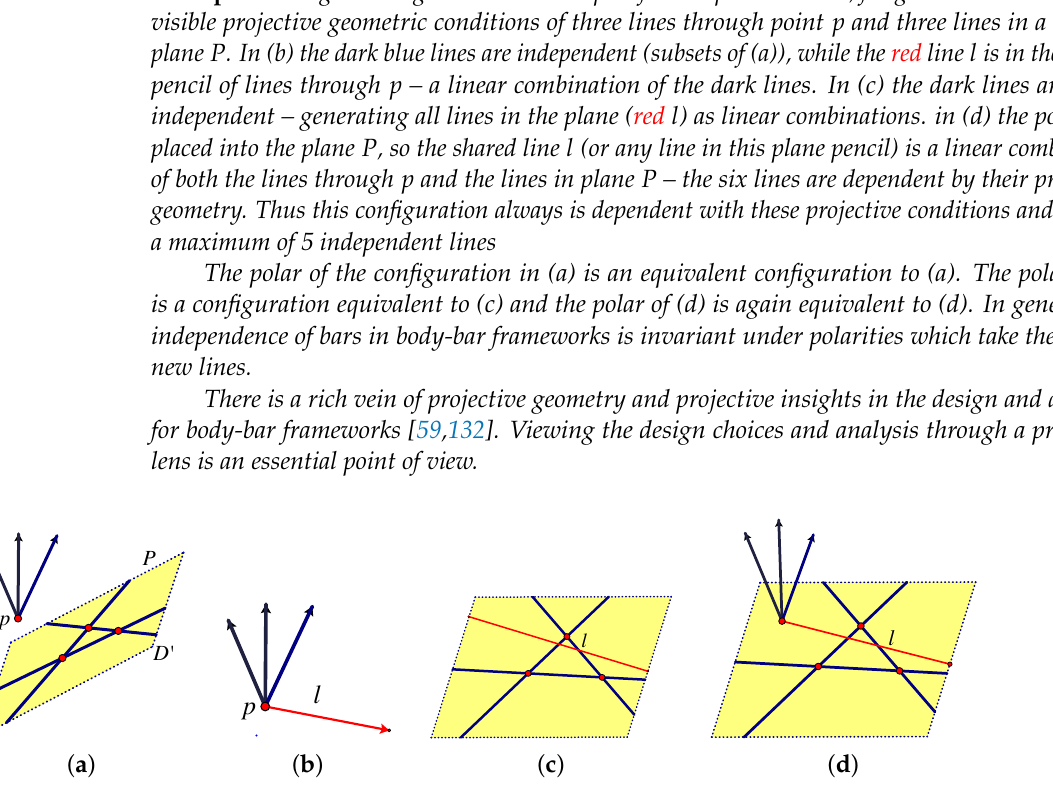
Figure 50. ( a ) shows 6 independent lines in space which generate all lines in space. ( b ) shows 3 lines through a point p which generate all lines through p , such as the added red line l . ( c ) shows three lines in a plane P which generate all lines in that plane, such as the added red line l . ( d ) shows 6 dependent lines when the point p in ( b ) lies in the plane P in ( c ) and they each generate the common line l